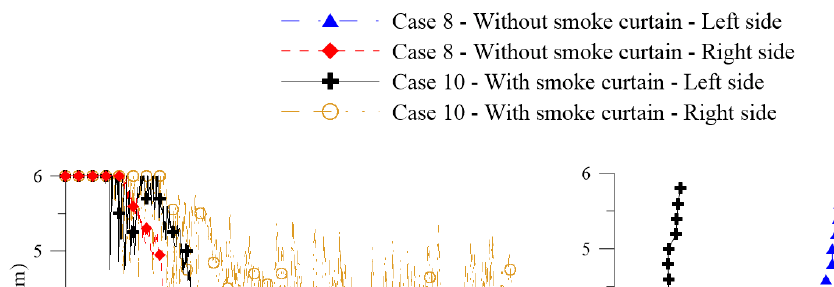
Figure 14. Pressure field in a plane that crosses two exhaust vents (y = 3.75 m) at time t = 600 s (case 10).